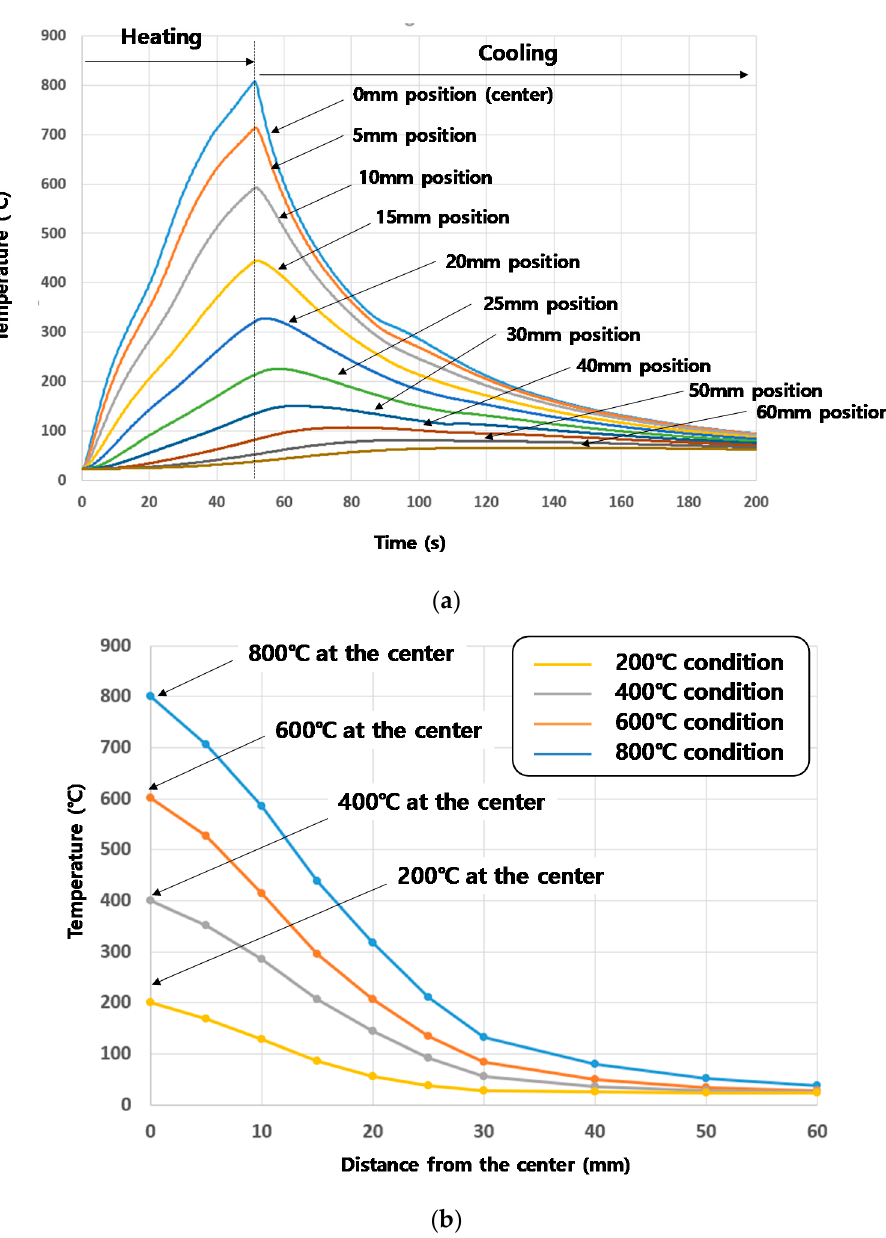
Figure 3. Results of the local heating test; ( a ) Heating and cooling rate at each measurement position; ( b ) Temperature distributions.